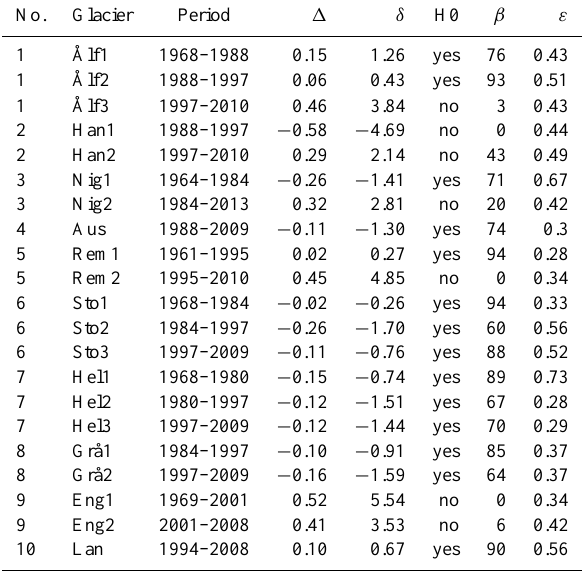
Table 5. Comparison of glaciological and geodetic mass balances. (cid:49) (inmw.e.a − 1 ) is the difference over the period of record between cumulative glaciological balance and geodetic balance, corrected for internal ablation. δ (dimensionless) is the reduced discrepancy, where uncertainties are accounted for. β is the probability of ac- cepting H0 although the results of the two methods are different at the 95% confidence level, while ε (in mw.e.a − 1 ) is the limit for detection of bias. Bold is used to highlight periods with less than 10 years length, differences larger than 0.20mw.e.a − 1 , and reduced discrepancies larger than